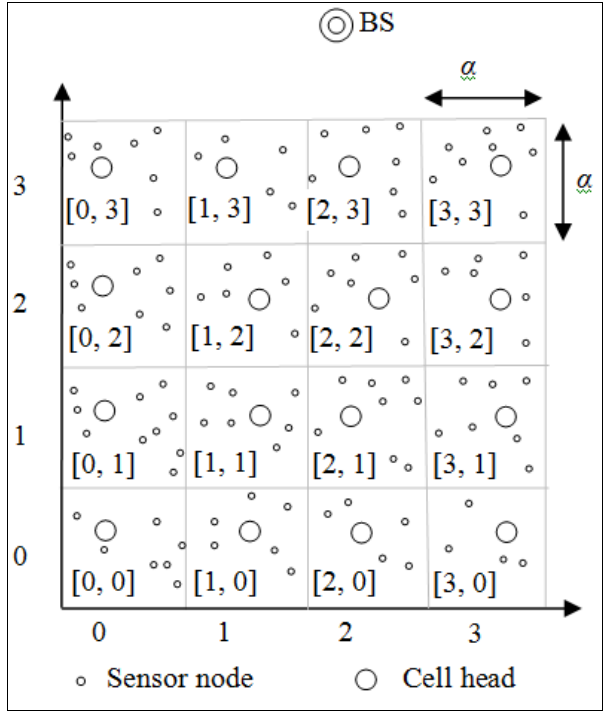
Figure 1. The logical grid